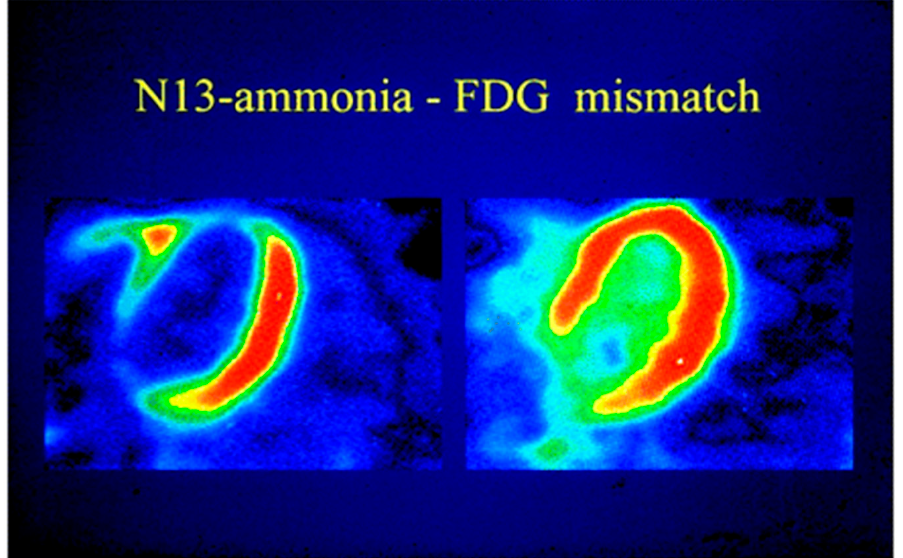
Figure 2. Viability imaging with PET using 13 NH 3 and 18 F-FDG. Viable tissue can be identified based on the mismatch between reduced myocardial blood flow seen by poor 13 NH 3 uptake ( left ) and normal myocardial metabolism of 18 F-FDG ( right ). Reproduced from Schinkel et al., 2007 by permission of J. Nucl. Med. [50] .